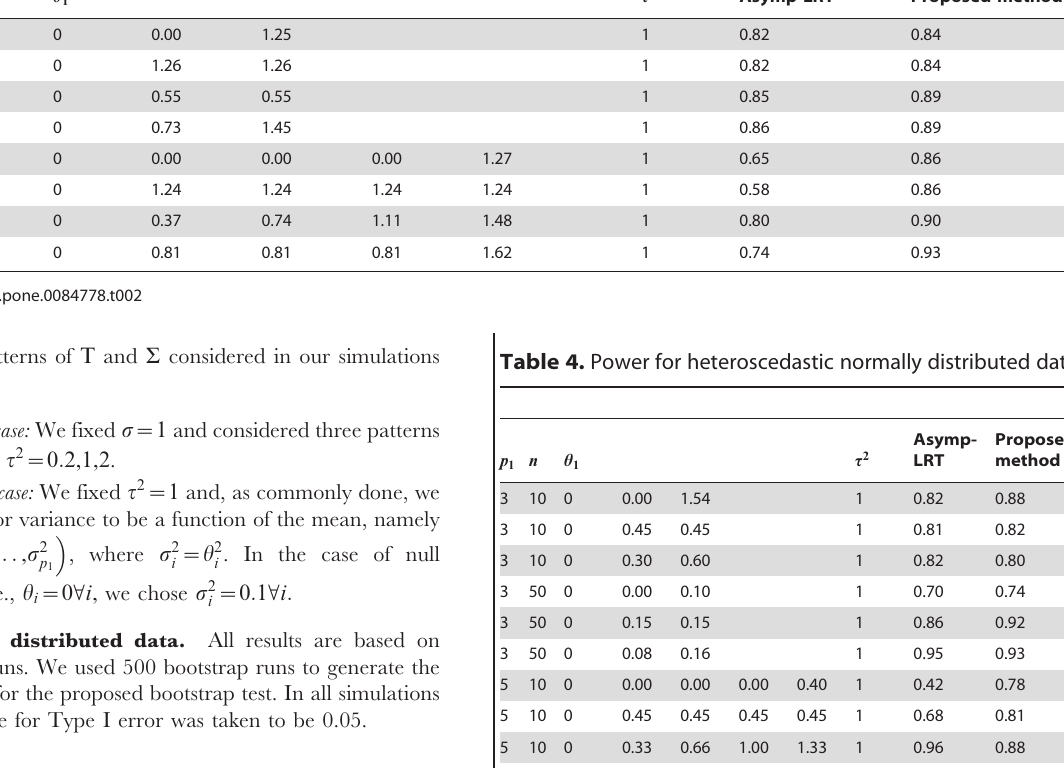
We illustrate the proposed methodology using data from patients in a randomized placebo-controlled, double-blind clinical trial the Treatment of Lead-exposed Children trial, or TLC [30].